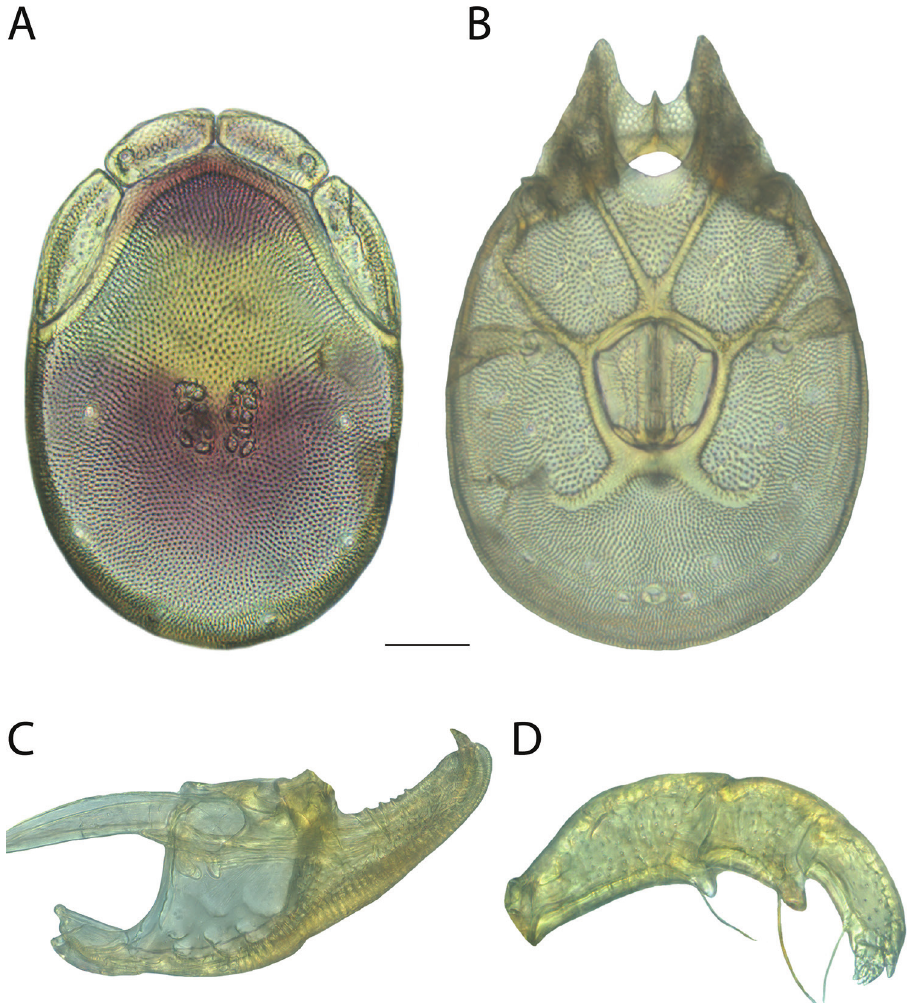
Figure 224. Torrenticola robisoni sp. n. female: A dorsal plates B venter (legs removed) C subcapitulum D pedipalp (setae not accurately depicted). Scale = 100